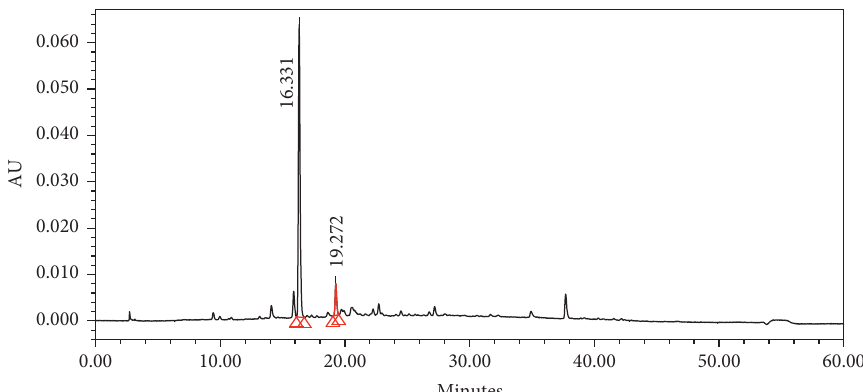
Figure 6: Normal-phase HPLC profile of Phaleria macrocarpa (leaf) with minute concentration of vitexin and isovitexin identified at a retention time of 21.834 and